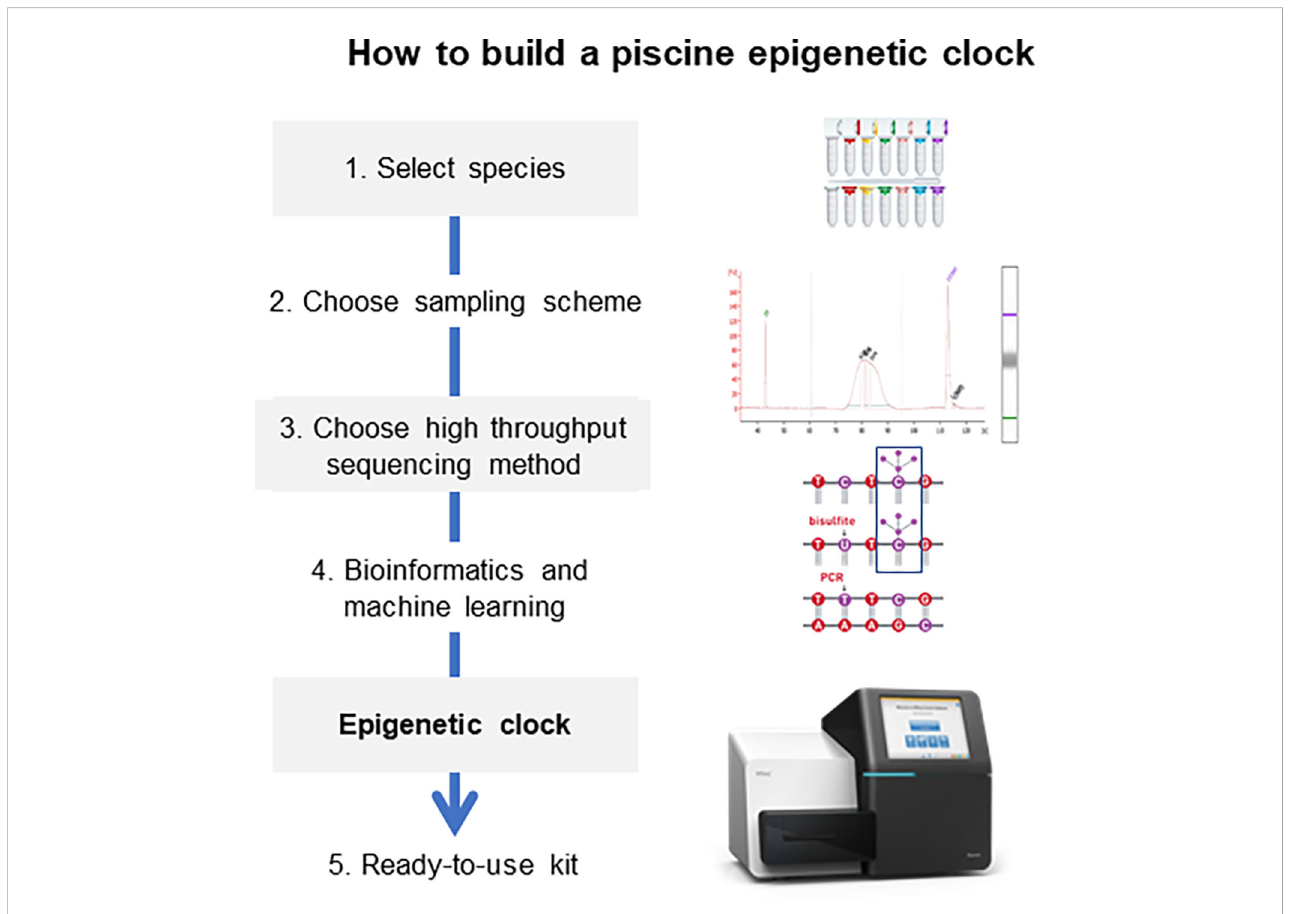
FIGURE 3 General procedure for the development of epigenetic clocks. Notice that in the bioinformatics pipeline not all samples are used in the same manner; some are used for the train set while others are used for the test set (Anastasiadi and Piferrer,